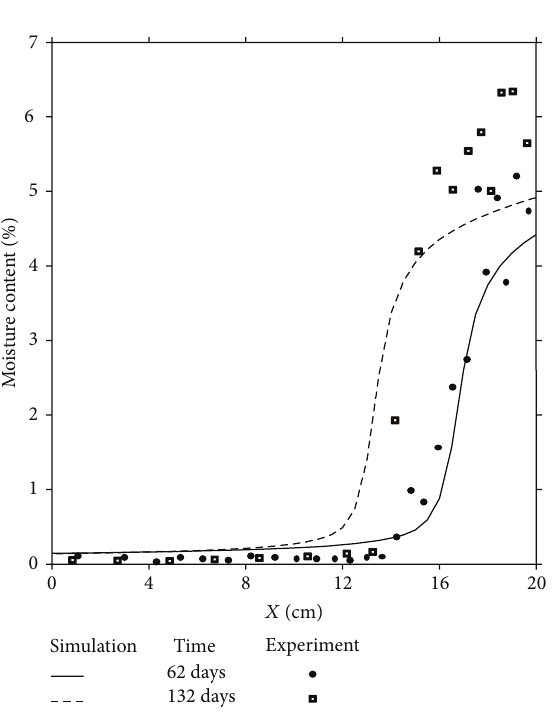
Figure 5: Moisture content distributions for 𝑡 = 62 days and 𝑡 = 135 days. Comparison between experiment and numerical